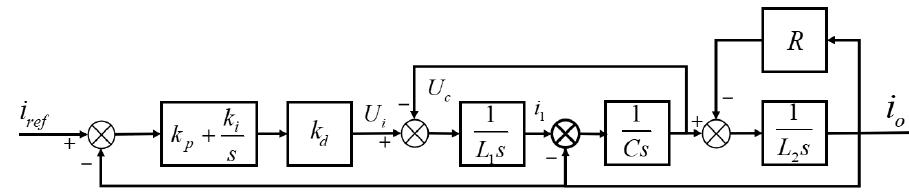
Figure 6. PI controller structure diagram.